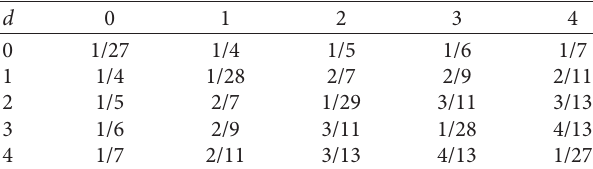
Table 1: Metric d defined in Example